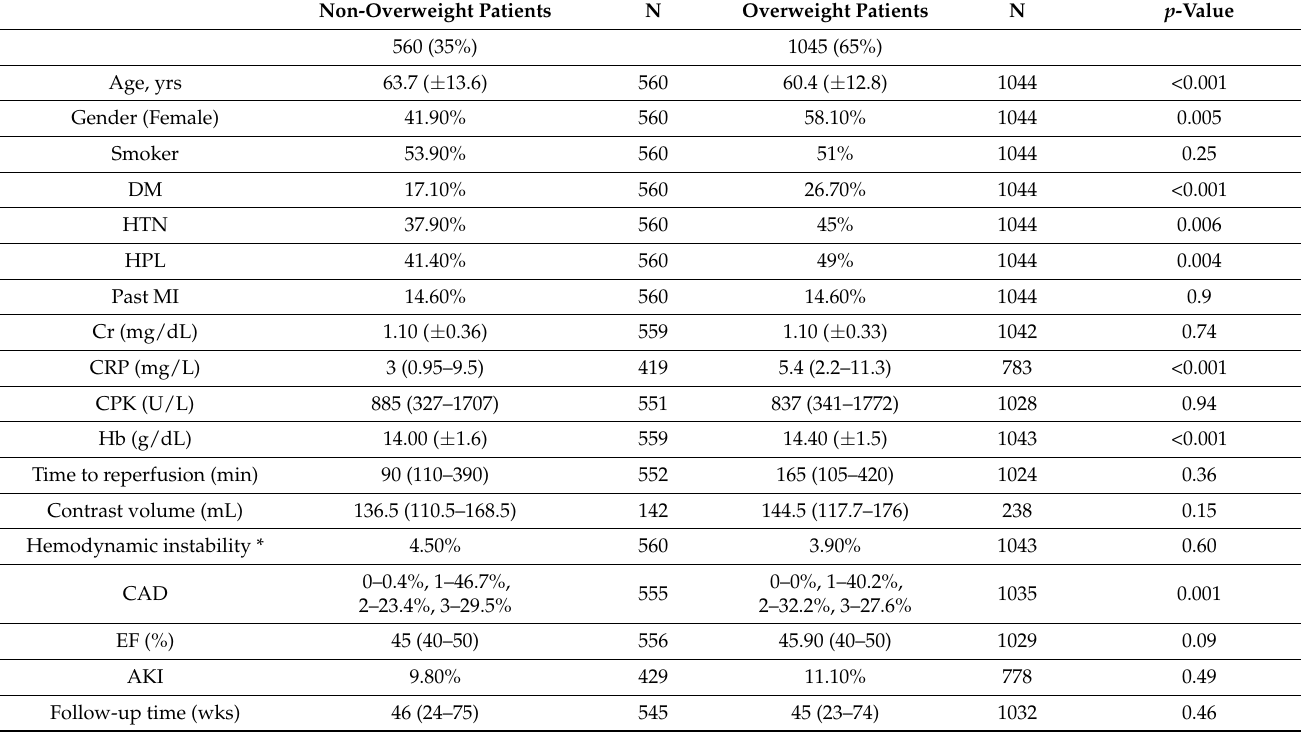
Table 2. Baseline characteristics of patients who are overweight (BMI > 25) and not overweight. Non-Overweight Patients N Overweight Patients N p